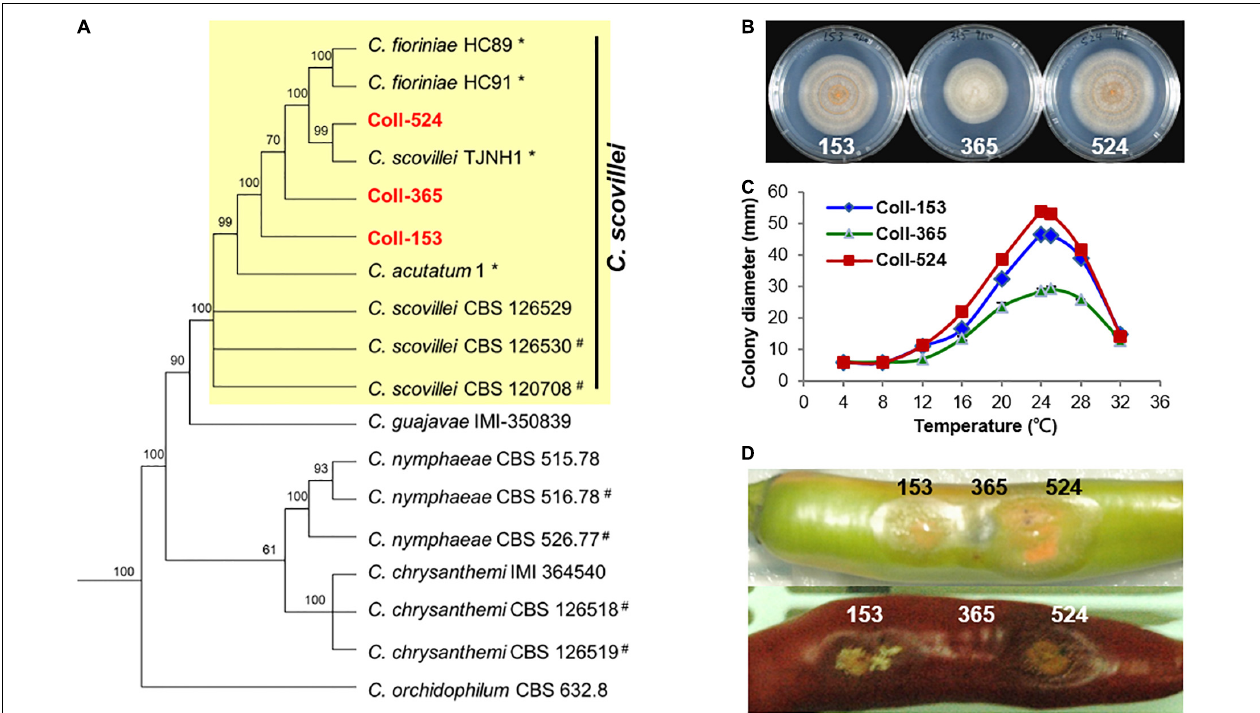
FIGURE 2 | Phylogenic relationships (A) , colony morphology (B) , growth at various temperatures (C) , and virulence on chili pepper (D) of the three strains Coll-524, Coll-153, and Coll-365. (A) Multi-locus phylogenetic tree of 18 Colletotrichum strains of acutatum species complex was constructed with five molecular markers (ACT1, CHS1, GAPDH, ITS, and TUB2). Yellow square indicated that Coll-153, Coll-365, and Coll-524 were in the same clade with C. scovillei CBS 126529, the holotype strain of C. scovillei . Detail information for the 18 strains was in Supplementary Table 1 . Posterior probability support values were indicated on branches. (B) Colony morphology of the three strains culturing on MS agar media for 6 days. (C) Growth of the three strains on various temperatures on PDA for 7 days. (D) Symptom of the three strains on green and red chili pepper fruits cv. Groupzest. Among the three strains, Coll-524 caused the largest lesion, while Coll-365 caused smallest